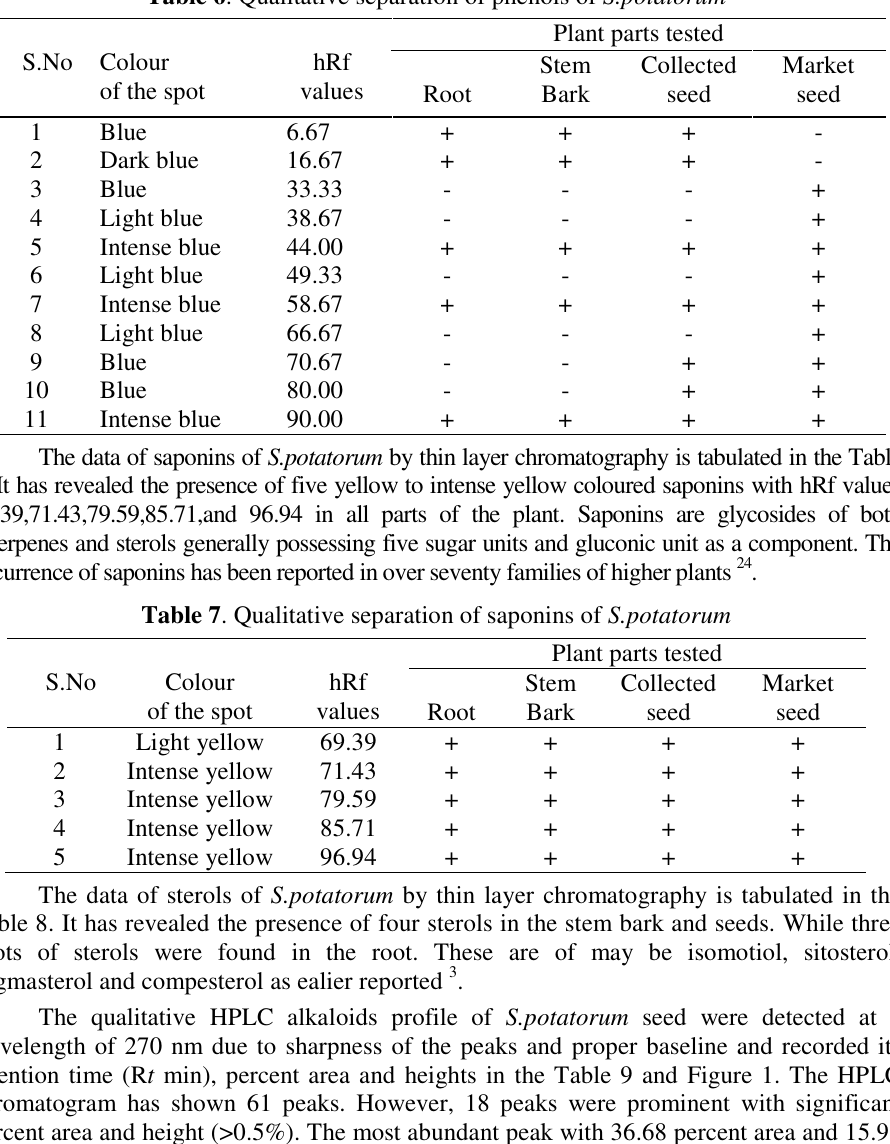
Table 6 . Qualitative separation of phenols of S.potatorum